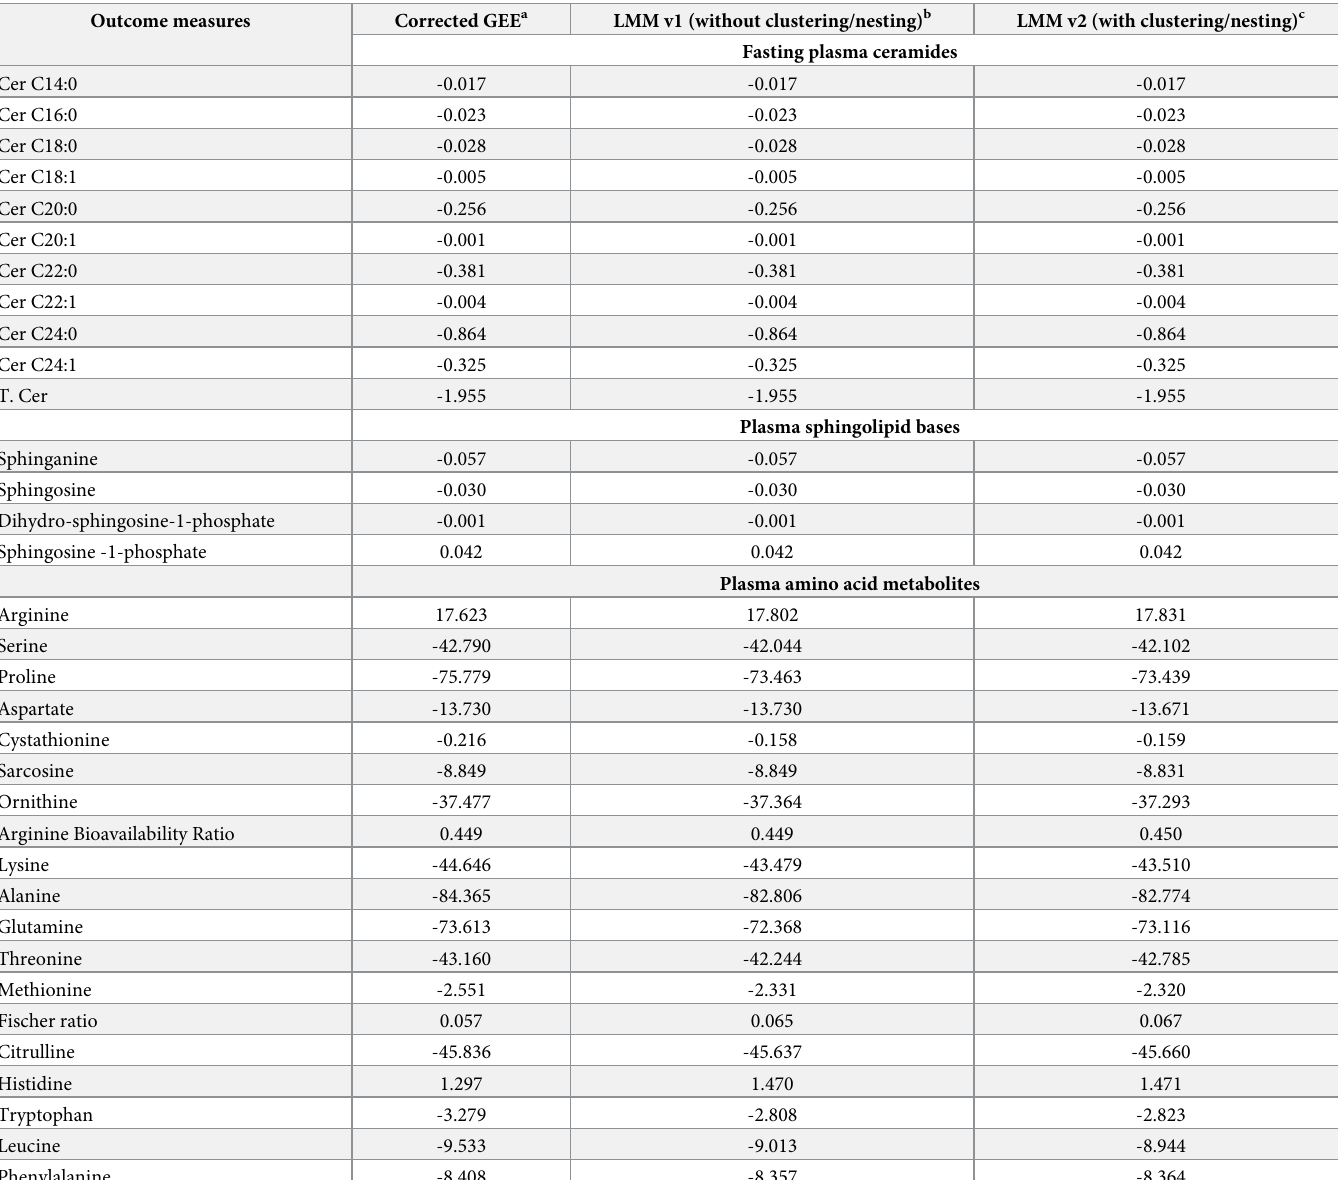
Table 2. Time x group interaction regression coefficient from generalized estimating (GEE) and linear mixed effect models (LMM). Outcome